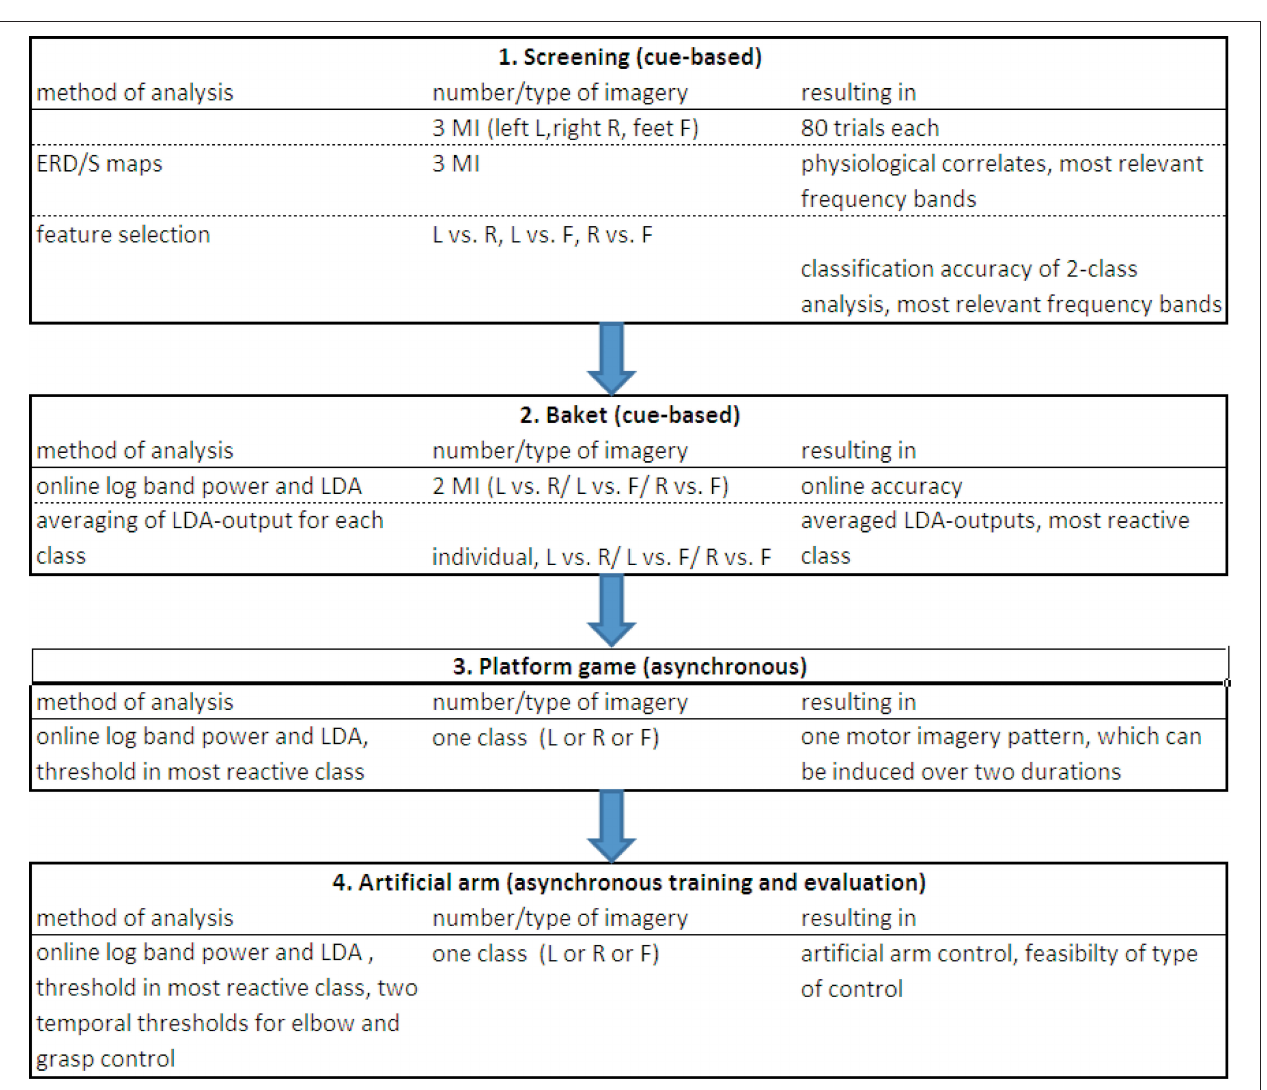
and classification, individual two types were selected and used in the Basket paradigm. From those results, the most reactive pattern was chosen to be used for the platform game and following in the arm